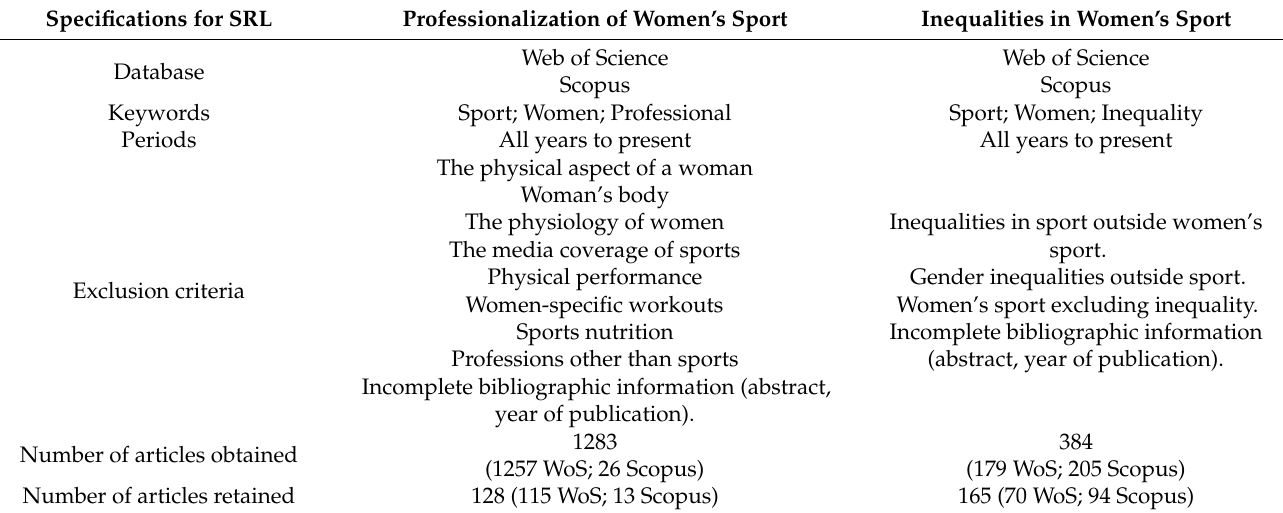
Table 2. Systematic literature review design I.